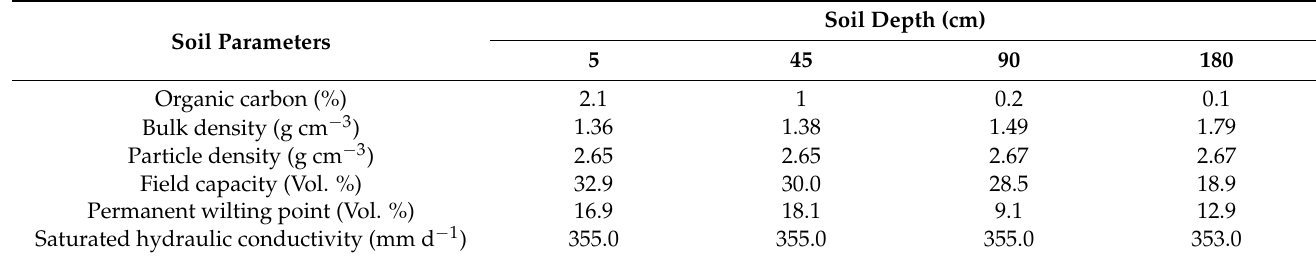
Table 1. Some soil parameters in Bad Lauchstaedt at different soil depths.